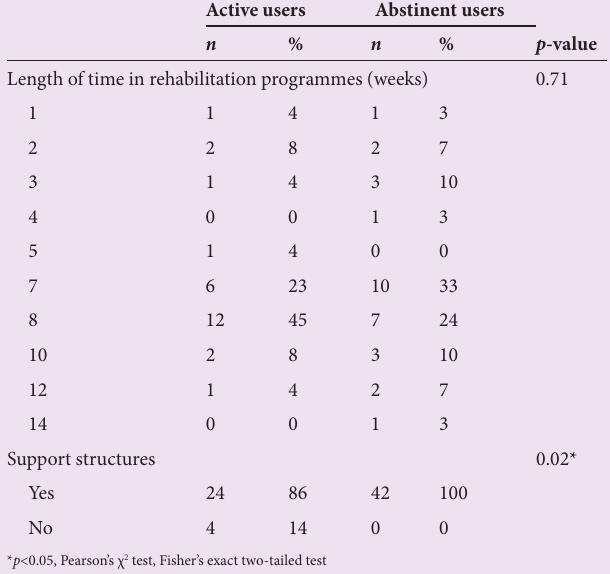
Table 4. Treatment data of active heroin users v. abstinent users during the 4 years after admission for heroin detoxification at the Opioid Detoxification Unit at Stikland Hospital